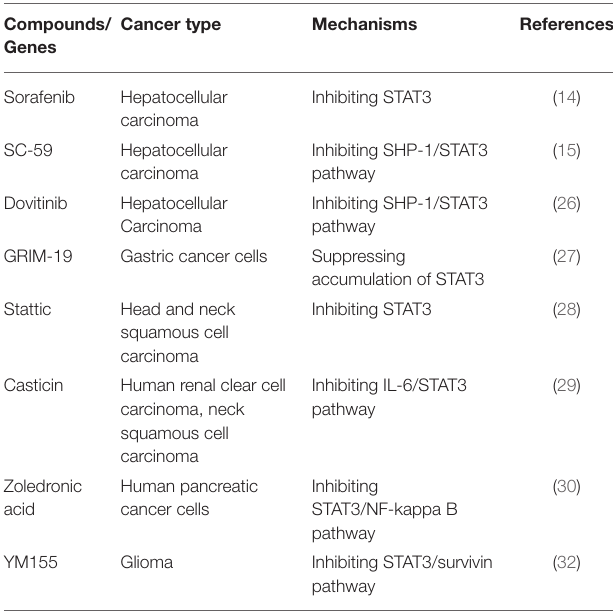
TABLE 1 | A summary of pre-clinical studies in which STAT3-targeted compounds are used to enhance the radiosensitivity of malignant tumors by inducing